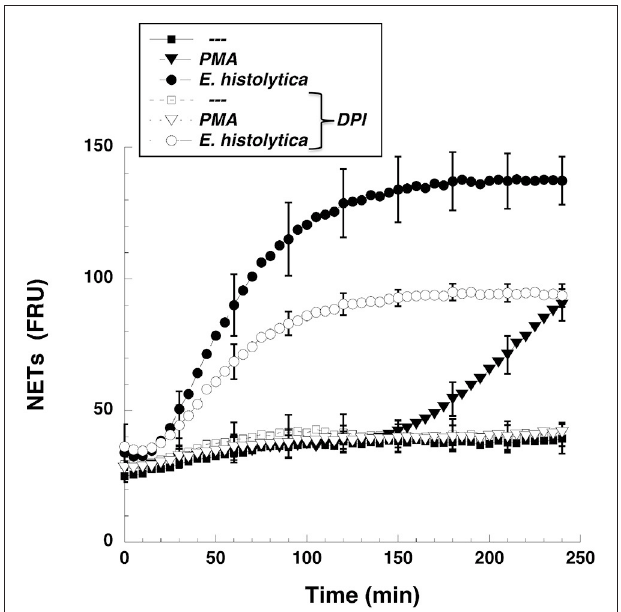
FIGURE 8 | The NADPH-oxidase inhibitor DPI reduced Entamoeba histolytica- induced NETs formation. Human neutrophils were not stimulated (—), or were stimulated with 20 nM phorbol 12-myristate 13-acetate (PMA), or with E. histolytica trophozoites . Some neutrophils were previously treated with 10 µ M diphenyleneiodonium (DPI), a NADPH-oxidase inhibitor (open symbols). The relative amount of NETs was estimated from SYTOX ® Green fluorescence in relative fluorescent units (RFU) during 4h after stimulation. Data are mean ± SEM of three experiments.